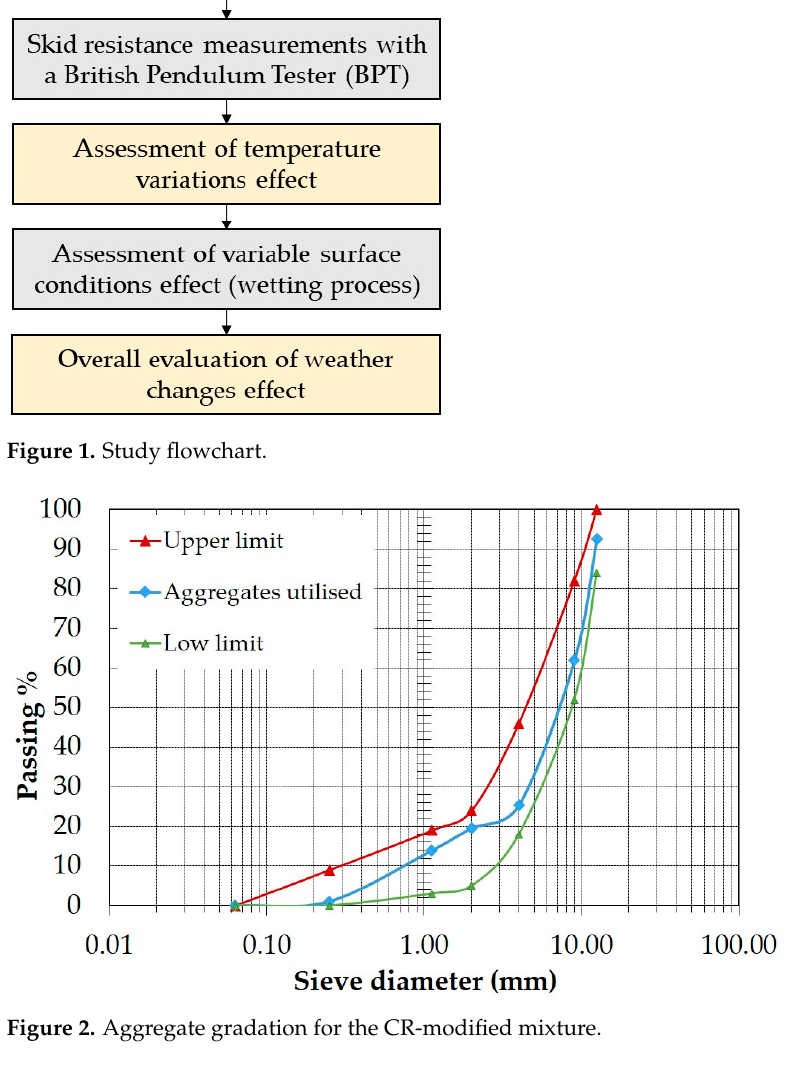
Figure 1. Study flowchart.